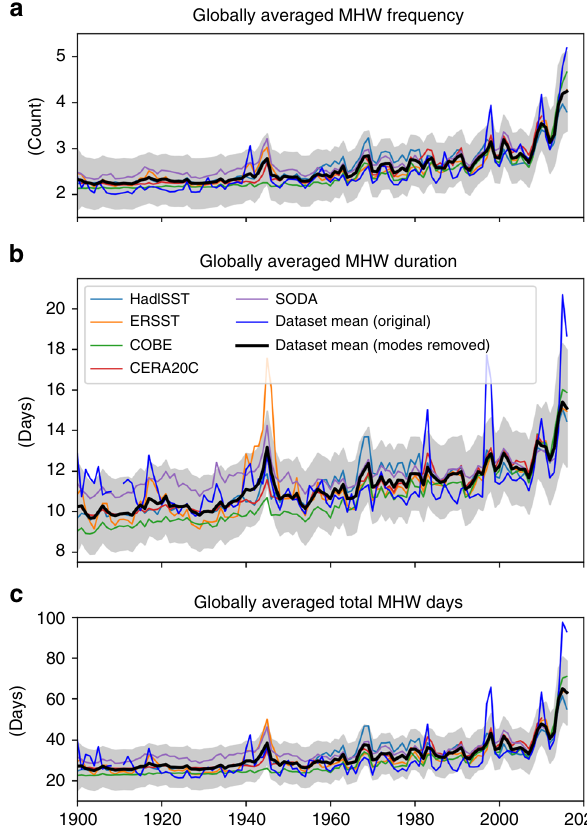
Fig. 6 In fl uence of climate modes on marine heatwaves globally. Globally averaged time series of annual ( fi rst row) marine heatwave (MHW) frequency, (second row) duration and (third row) total MHW days based on monthly proxies over 1900 – 2016. Shown are the original results which include the in fl uence of major global-scale climate modes (i.e., ENSO, PDO, AMO; blue lines) and results after the removal of their global signature (thin coloured lines and thick black lines). The shaded areas show the 95% con fi dence intervals based on model errors, averaged across proxy data sets (taking into account temporal covariance; after removal of climate modes). Note that the blue lines in this fi gure are identical to the black lines in Fig.